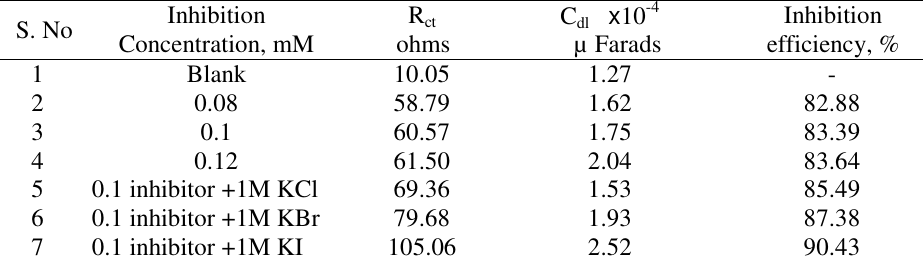
Table 7. Impedance parameters for the corrosion of mild steel in 1 M H without (01TD).